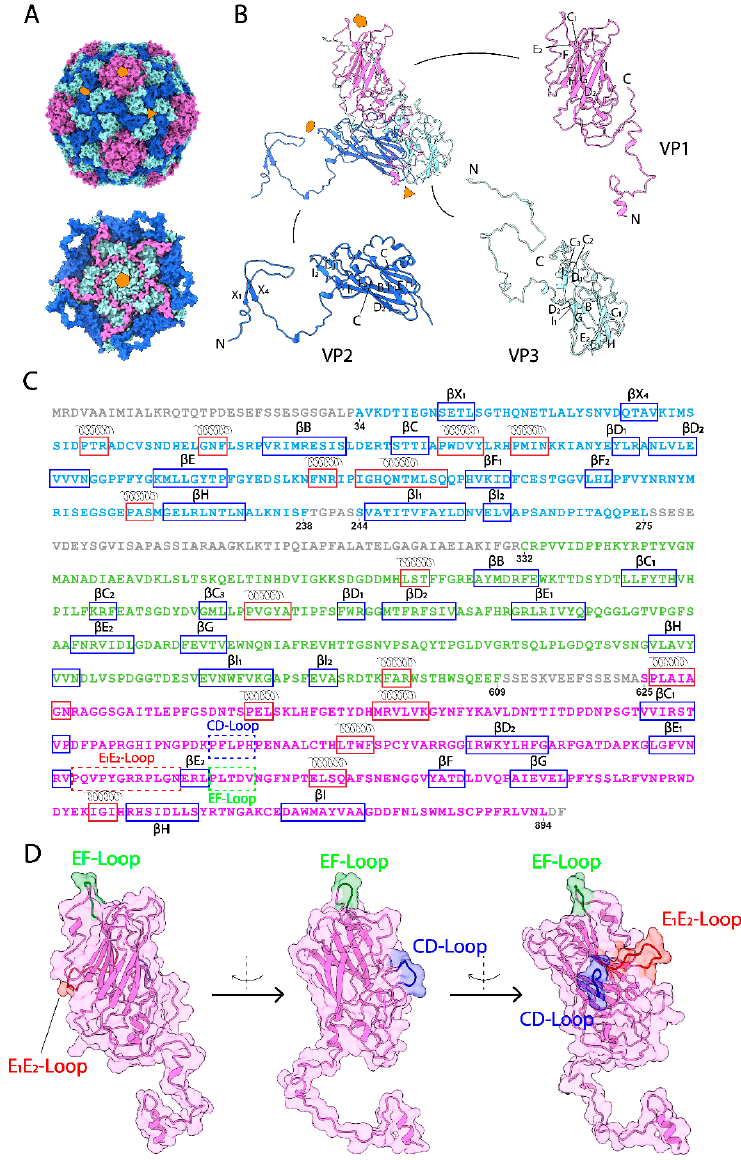
Figure 1. Overall CsfrRNAV CP structure and VPs atomic models. ( A ) Overall geometry of the CsfrRNAV CP ( top ) and the CP 5-fold interior view ( bottom ). Pentagon, triangle, and ellipse refer to 5-fold, three-fold, and two-fold, respectively. ( B ) Atomic models of VP1–3. N or C terminus is labeled. Other letters refer to each of the β -strands in each VP, according to the information shown in ( C ). ( C ) Amino acid sequence organization of the CsfrRNAV CP. Residues for VP1 are in pink, residues for VP2 are in blue, and residues for VP3 are in green. Red and blue rectangular boxes display the α -helices and β -strands. Dash boxes show special CD-Loop, E 1 E 2 -Loop, and EF-Loop in VP1. Unmodeled residues are in gray. ( D ) Images of three special loops in VP1. The CD-Loop, E 1 E 2 -Loop, and EF-Loop are shown in blue, red, and green, respectively, with the rotation to the left.